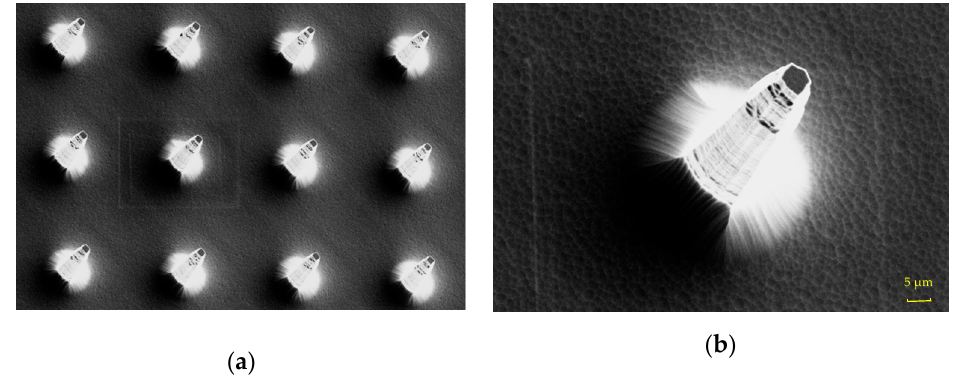
Figure 4. Characterization of conical microstructure after wet etching. ( a ) The morphology characterization diagram of silicon array with conical microstructure after wet etching; ( b ) the morphology characterization of single silicon column with conical microstructure. This top diameter of this structure is 5 μ m, the bottom diameter is 79 μ m, and the height is 98 μ m.